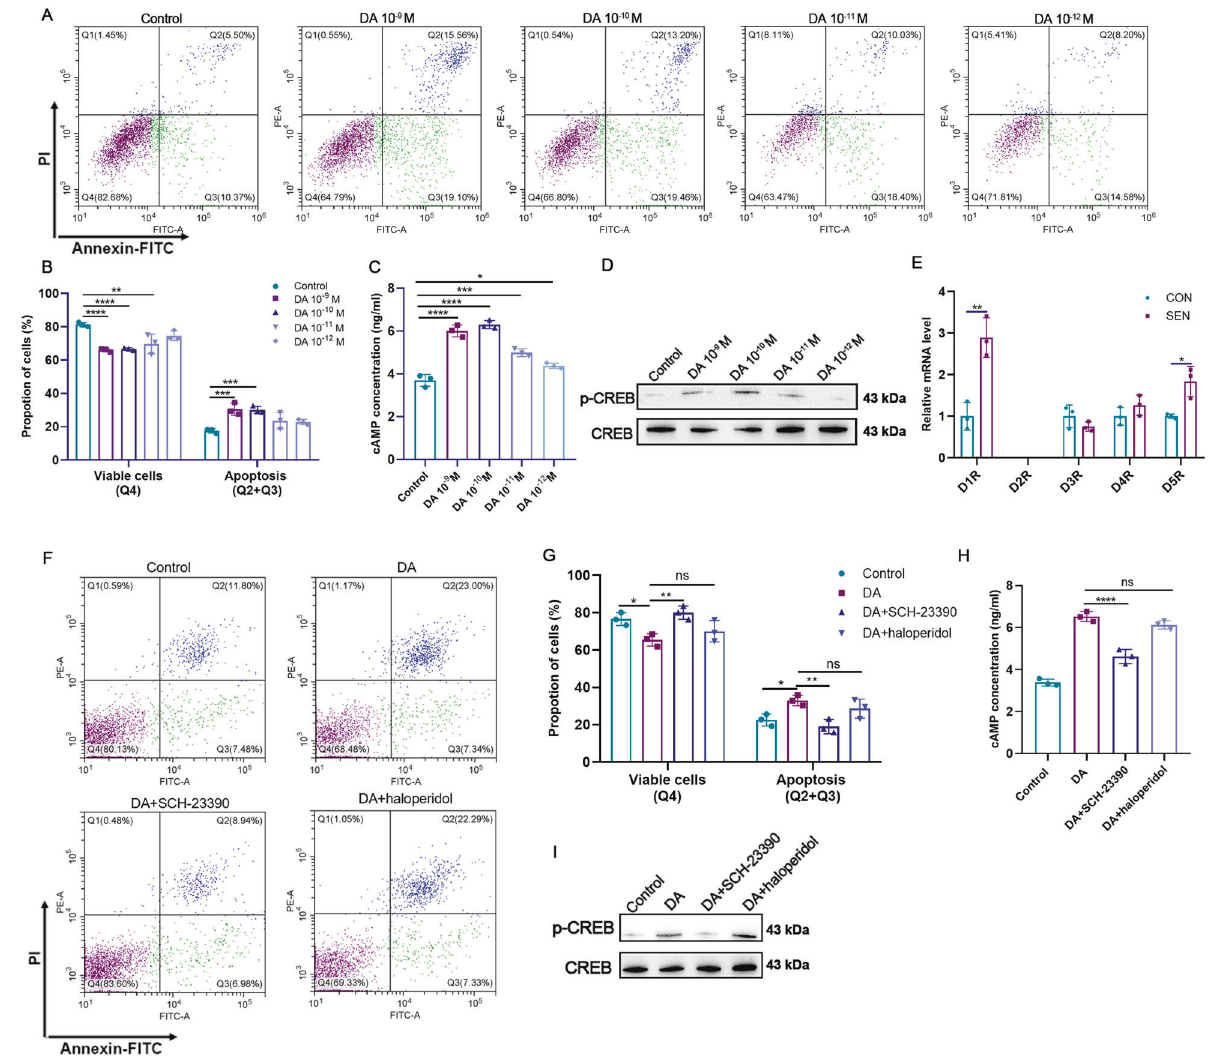
Fig. 4 DA enhances mouse NK cell cytotoxicity against SNCs through D1-like receptors. A , B Cytotoxicity of mouse NK cells against SNCs supplemented with different concentrations of DA after a 24-h co-incubation. n = 3. Data are presented as means ± SD. Differences were assessed by the two-way ANOVA test. ** P < 0.01, *** P < 0.001, **** P < 0.0001. C Data showing cAMP content in NK cells after 24-h incubation with SNCs supplemented with different concentrations of DA. n = 3. Data are presented as means ± SD. Differences were assessed by the one- way ANOVA test. * P < 0.05, *** P < 0.001, **** P < 0.0001. D Western blot analysis of phosphorylated CREB level in NK cells after 24-h incubation with SNCs supplemented with different concentrations of DA. E DR expression in NK cells was detected after co-incubation with SNCs